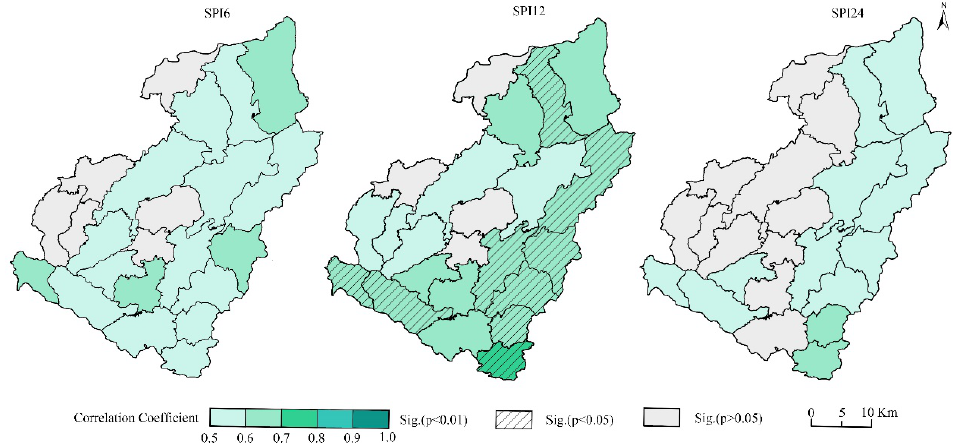
Figure 4. Spatial distribution of correlation coefficients between SPI and crop yield in towns of Yuzhong county.